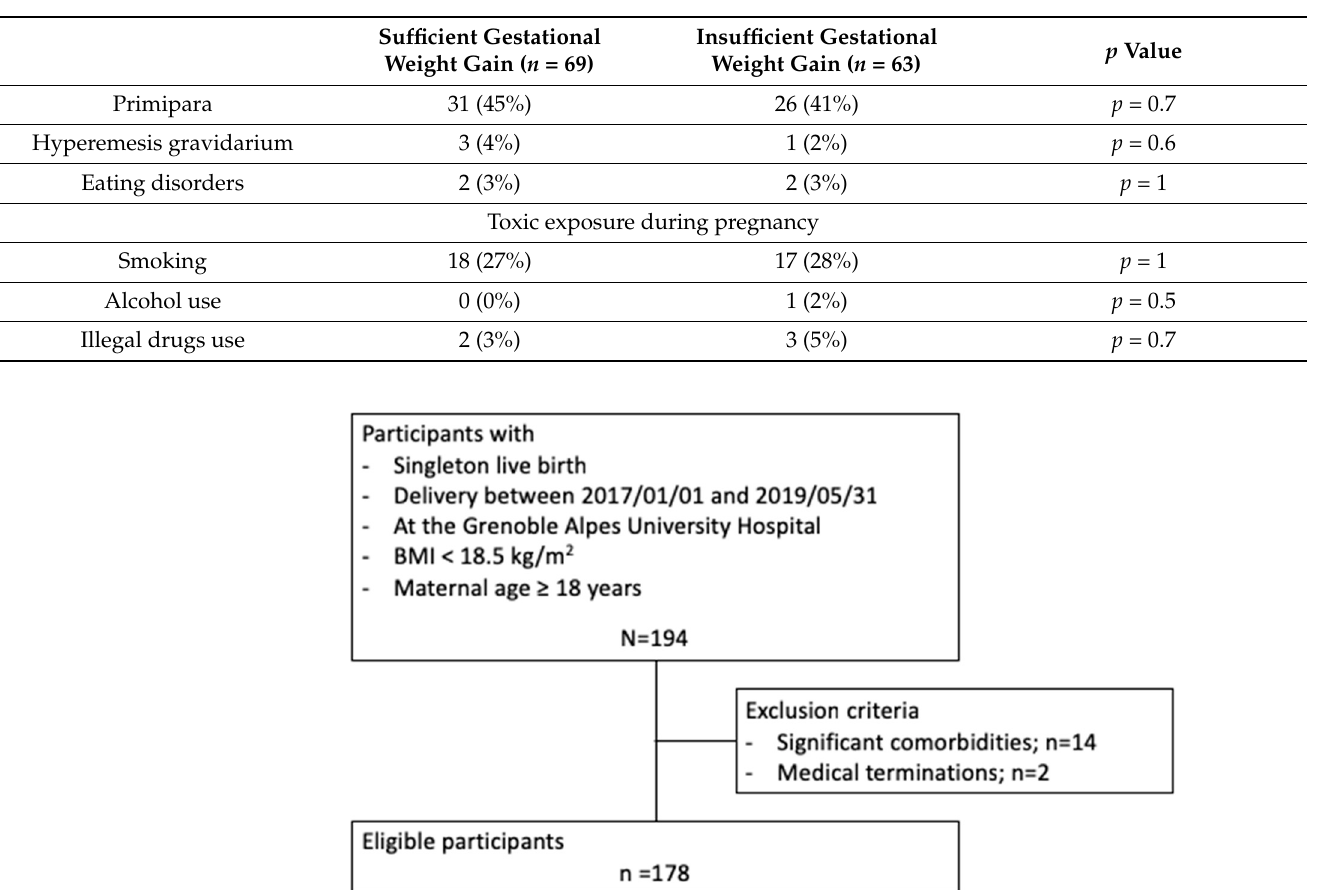
Table 1. Potential pregnancy risk factors of insufficient weight gain in median (IQR) or in number (frequency) according to the status of sufficient ( ≥ 12.5 kg) or insufficient (<12.5 kg · m − 2 ) gestational weight gain.